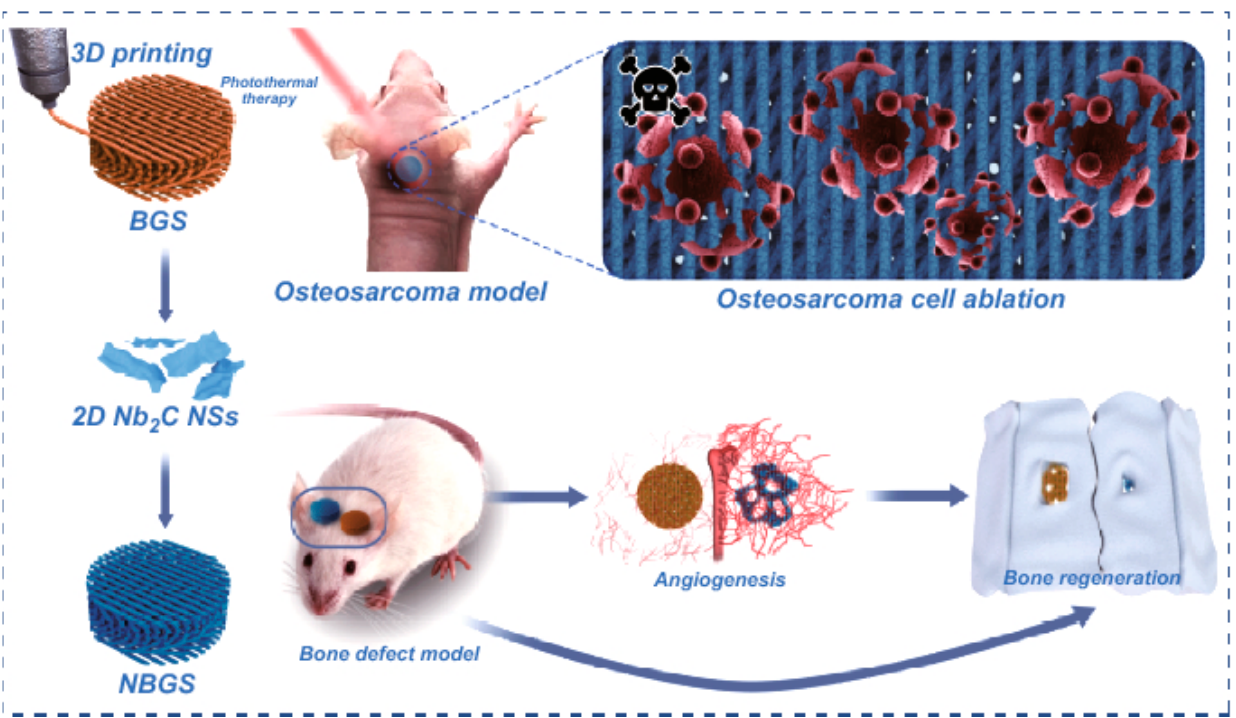
Figure 10. Process flow diagram for NBGS’s photothermal osteosarcoma ablation and bone regeneration. It is possible to encourage arterialization to improve osseous repair. Reprinted with permission from Ref. [83].